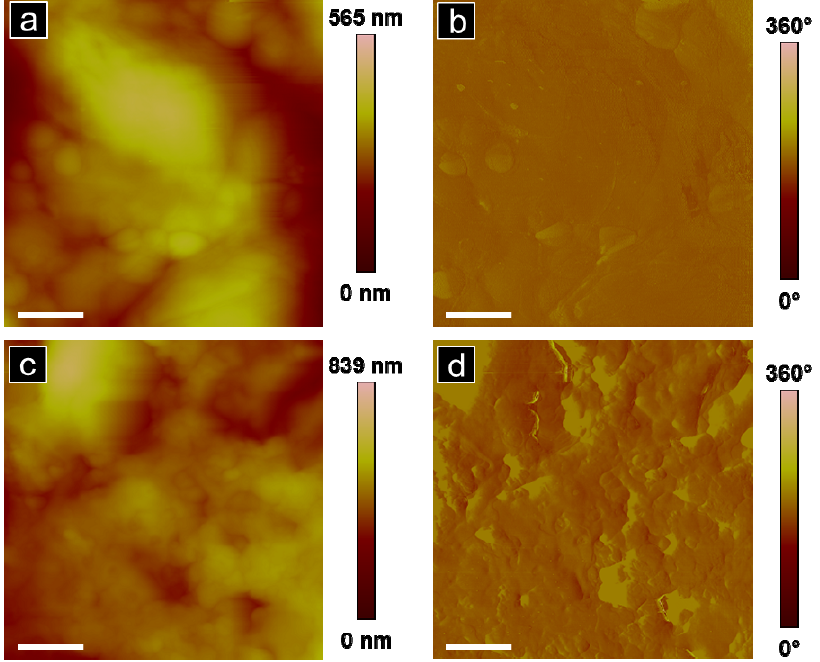
Figure 5. ( a and b ) AFM analysis of the dorsal striatum of a rat treated with G4 biotinylated PAMAM dendrimers: ( a ) topography and ( b ) phase image in a region where no dendrimers are observed. ( c and d ) AFM analysis of an untreated rat dorsal striatum (no systemic treatment of G4 biotinylated PAMAM dendrimers): ( c ) topography and ( d ) phase image. Scale bar is 1 µm for all